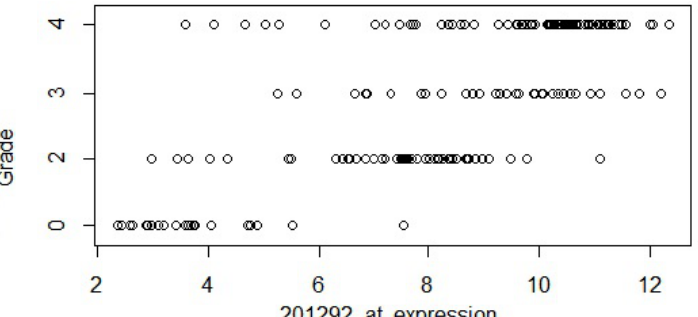
Figure 2: Expression/grade distribution for Affymetrix probeset 201292 at. Grade 0 corresponds to non-tumor samples and grade 1 was not represented on collected